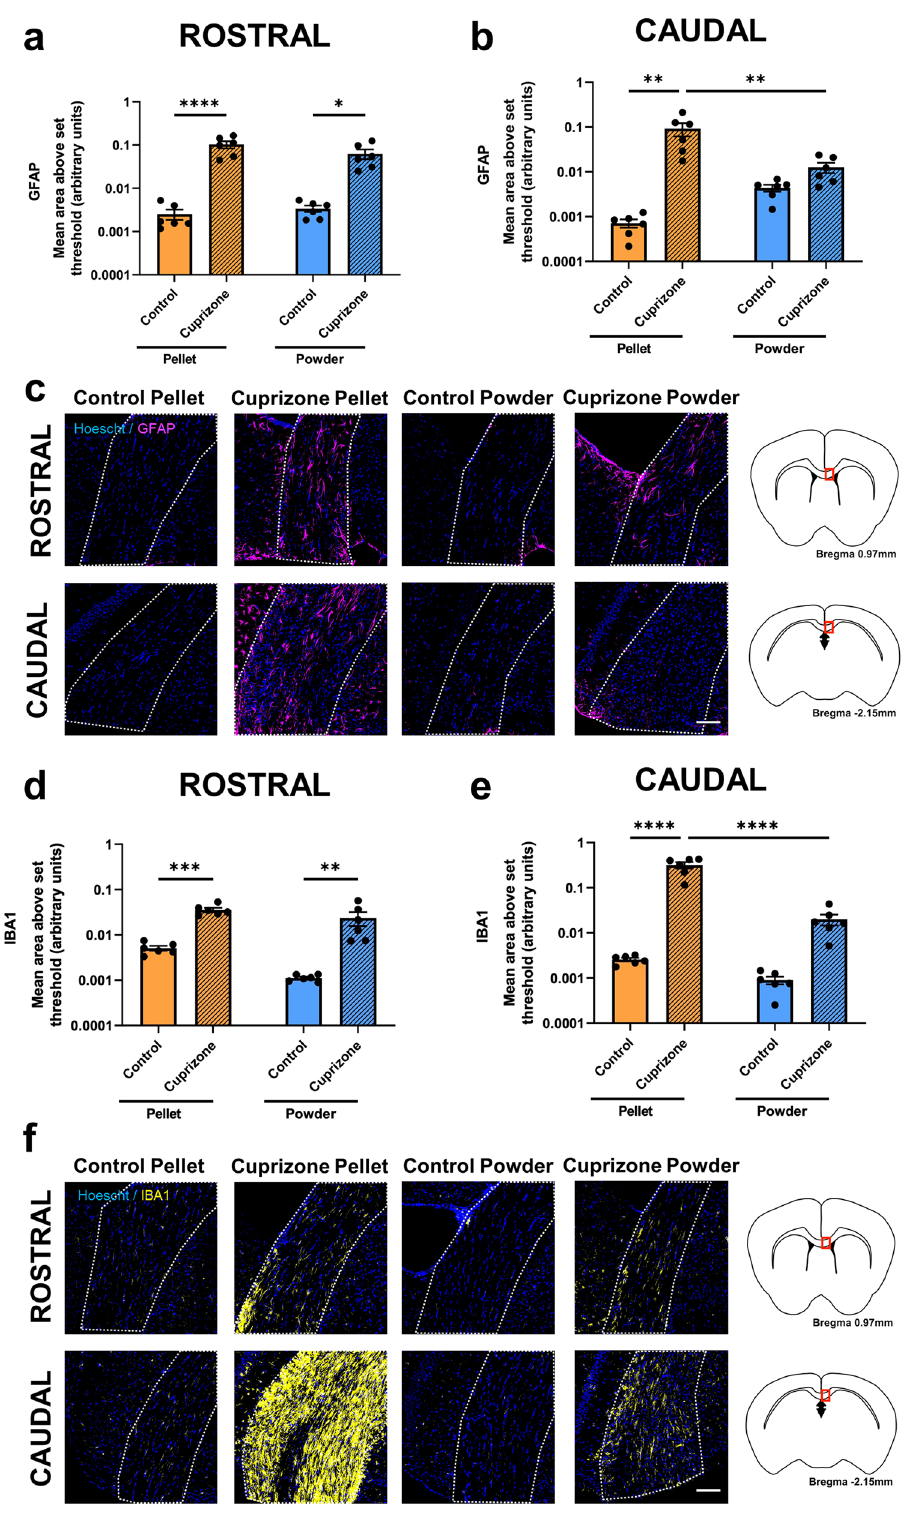
Figure 2. Effects of cuprizone feed formulation on glial reactivity. Area of immunointensity of GFAP in the rostral ( a ) and caudal ( b ) corpus callosum was assessed to determine the level of astrocyte reactivity. Area of immunointensity of IBA1 in the rostral ( d ) and caudal ( e ) corpus callosum was assessed to determine the level of microglial activation. N = 6 mice per group, graphs display individual data points overlayed on a bar displaying the mean ± SEM. Significant differences are indicated by *p ≤ 0.05,